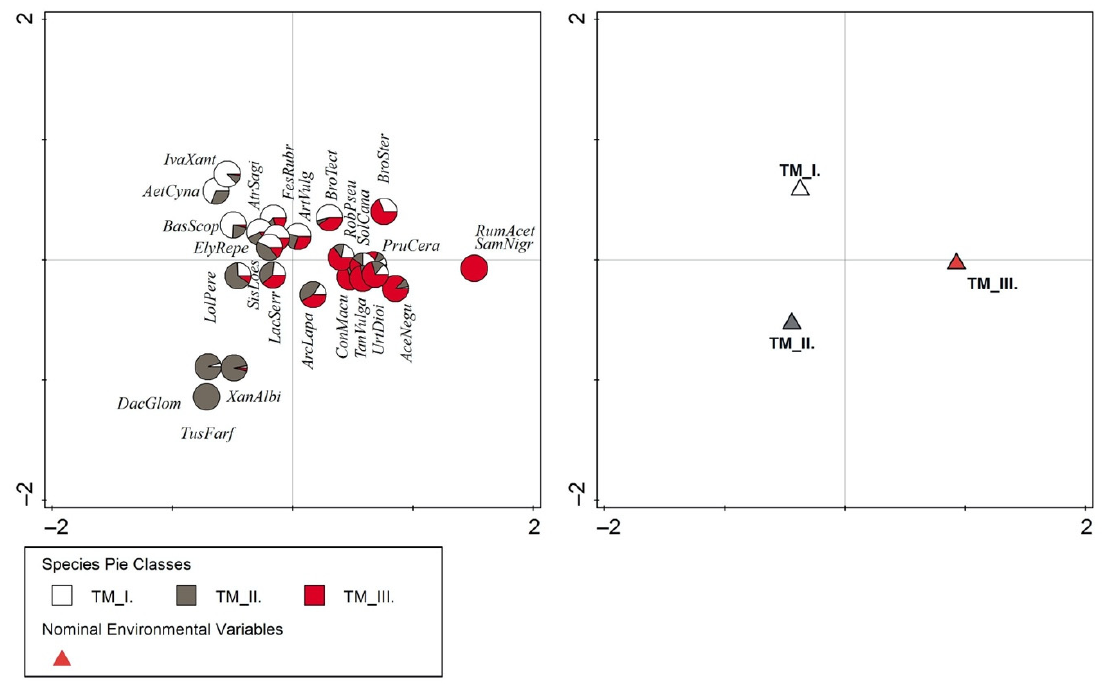
Figure 6. Relation between the sites with different development and the occurrence of plant species (CCA results; explanatory variables account for 30.4%; pseudo F = 2.4; p = 0.001). Abbreviations: